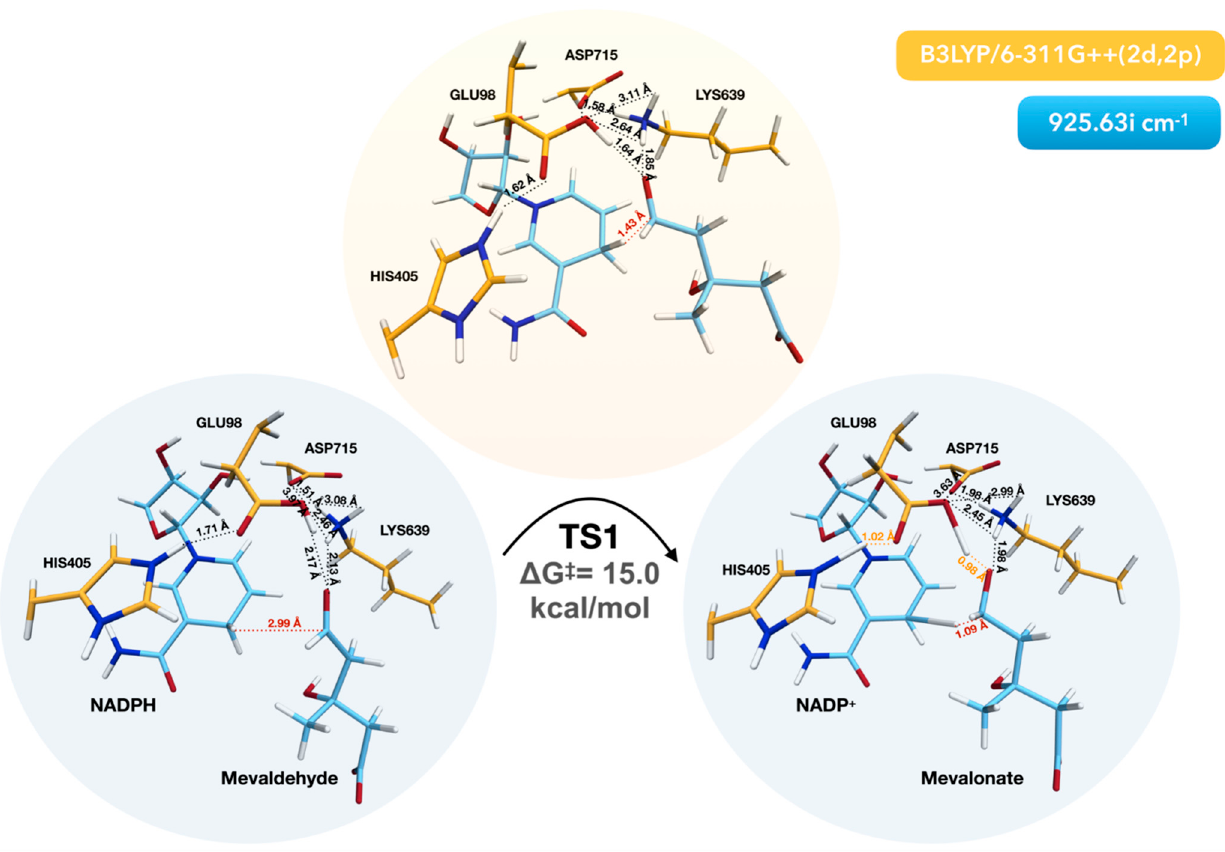
Figure 4. Reaction mechanism for a system with cationic His405 with corresponding imaginary frequency and distances between atoms important for reaction. All three structures represent optimized structures, and the imaginary frequency corresponds to the TS. The reaction coordinate followed was marked in red, whereas newly formed bonds are marked in orange. After the hydride transfer and the protonation by Glu98, mevalonate is formed with the proton exchange between His405 and